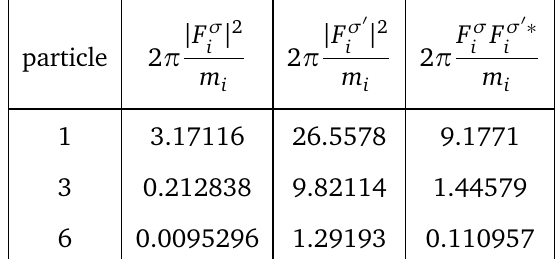
ij , i , j = σ , σ (cid:48) . S